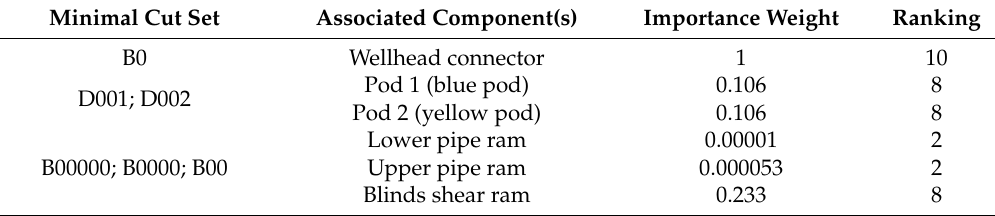
Table 3. Weights and rankings of some BOP components .